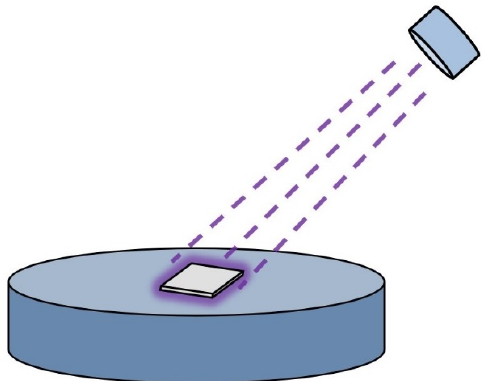
Figure 9. Schematic diagram of a sample illuminated by a light source.